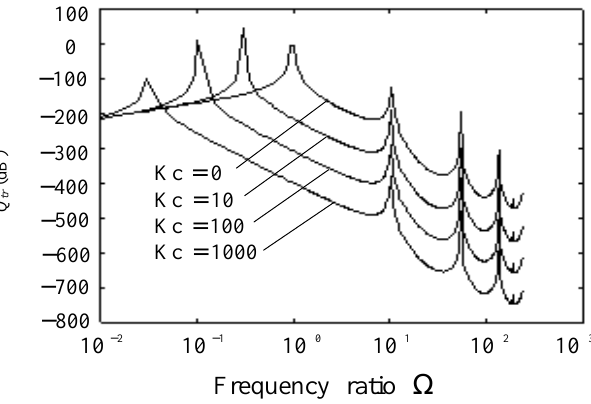
Fig. 5. Variation of power flow spectra to different feedback gain values ( µ = 0 . 5 ,ω 1 /ω 0 = 10 ,γ = 2 ,δ = 0 . 001 ,ξ = 0 . 01 ). It is known that the passive vibration isolation